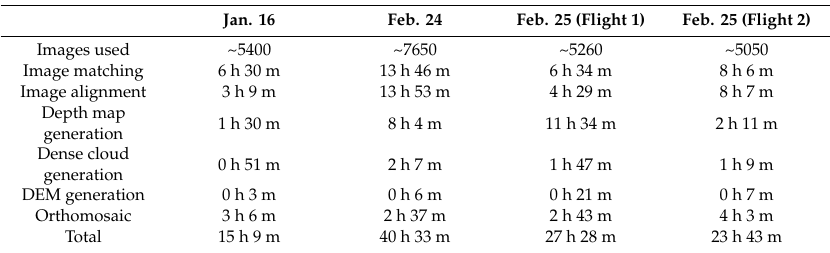
Table 2. Details on processing time required for the UAV imagery for the four flights. The settings within the Agisoft software used for processing include “high” accuracy for camera alignment / sparse cloud generation, with a key point / tie point limit of 40,000 / 4000, respectively. The dense cloud was generated using the “low” quality setting with “aggressive” point